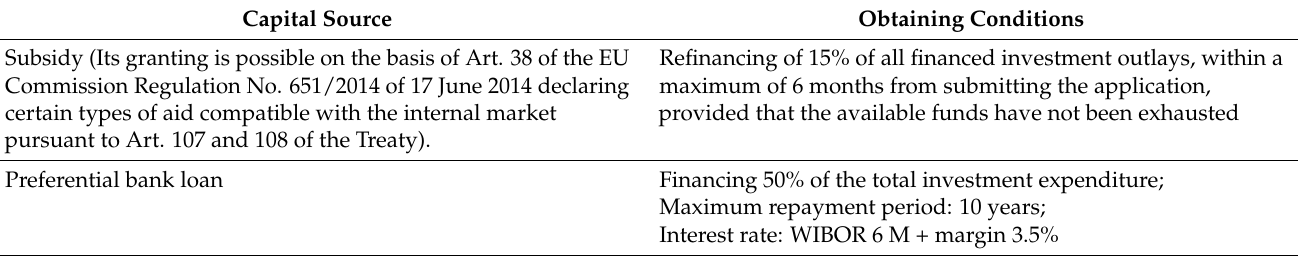
Table 14. List and conditions for obtaining capital that can be used to finance a project. Source: designed by authors.